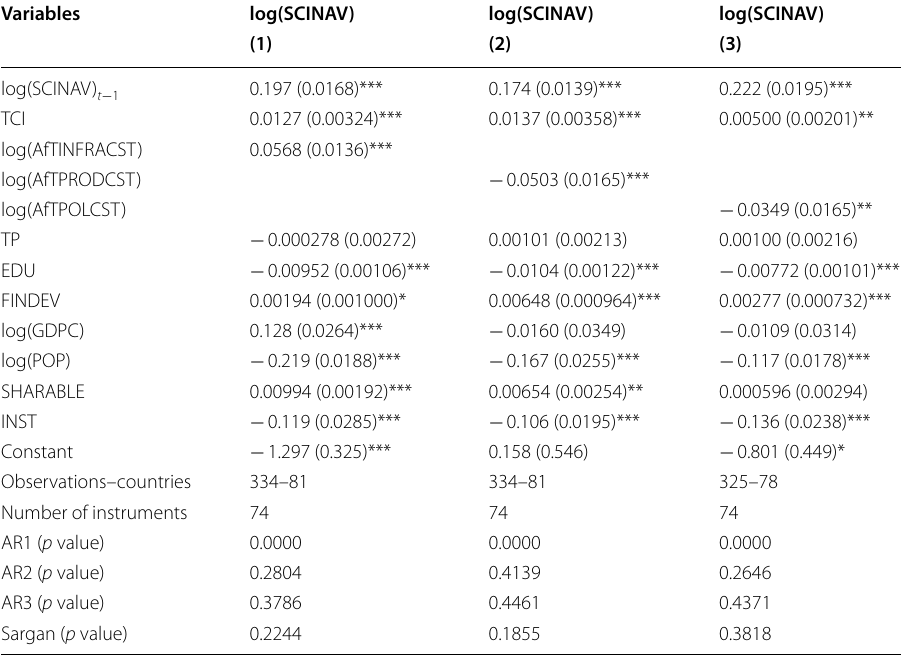
Table 3 Effect of the components of AfT flows and development strategy on structural change in